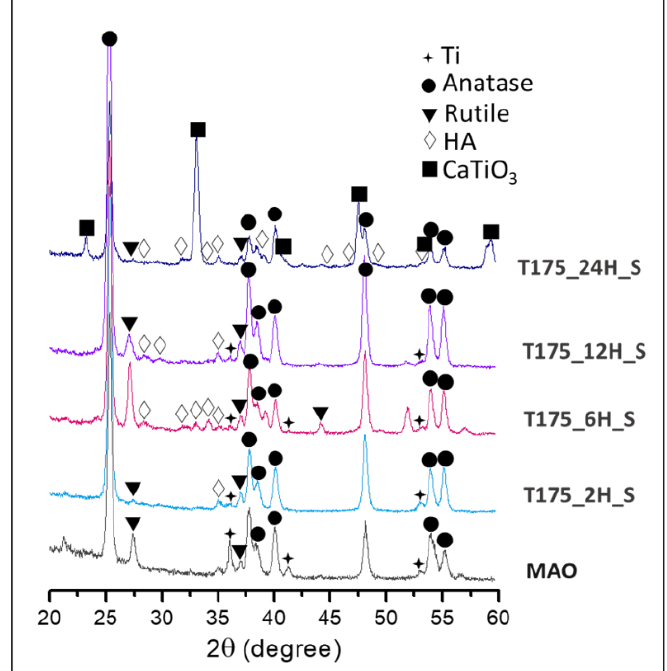
Figure 6. The XRD spectra of the MAO coating and the hierarchical structures fabricated using hydrothermal treatment at 175 °C for 2, 6, 12, and 24 hours.